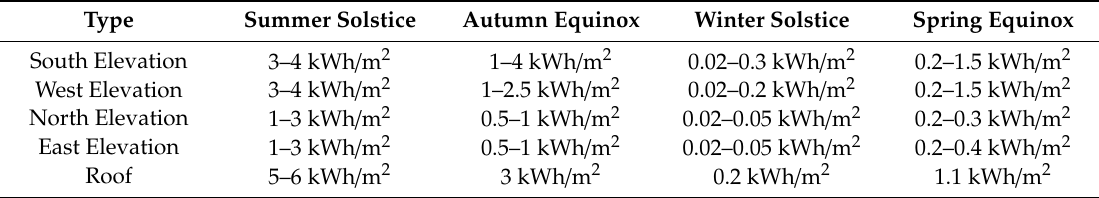
Figure 5. Annual sun radiation energy analysis for designed building. Table 2. Sun radiation for the elevations in presented on chosen dates.